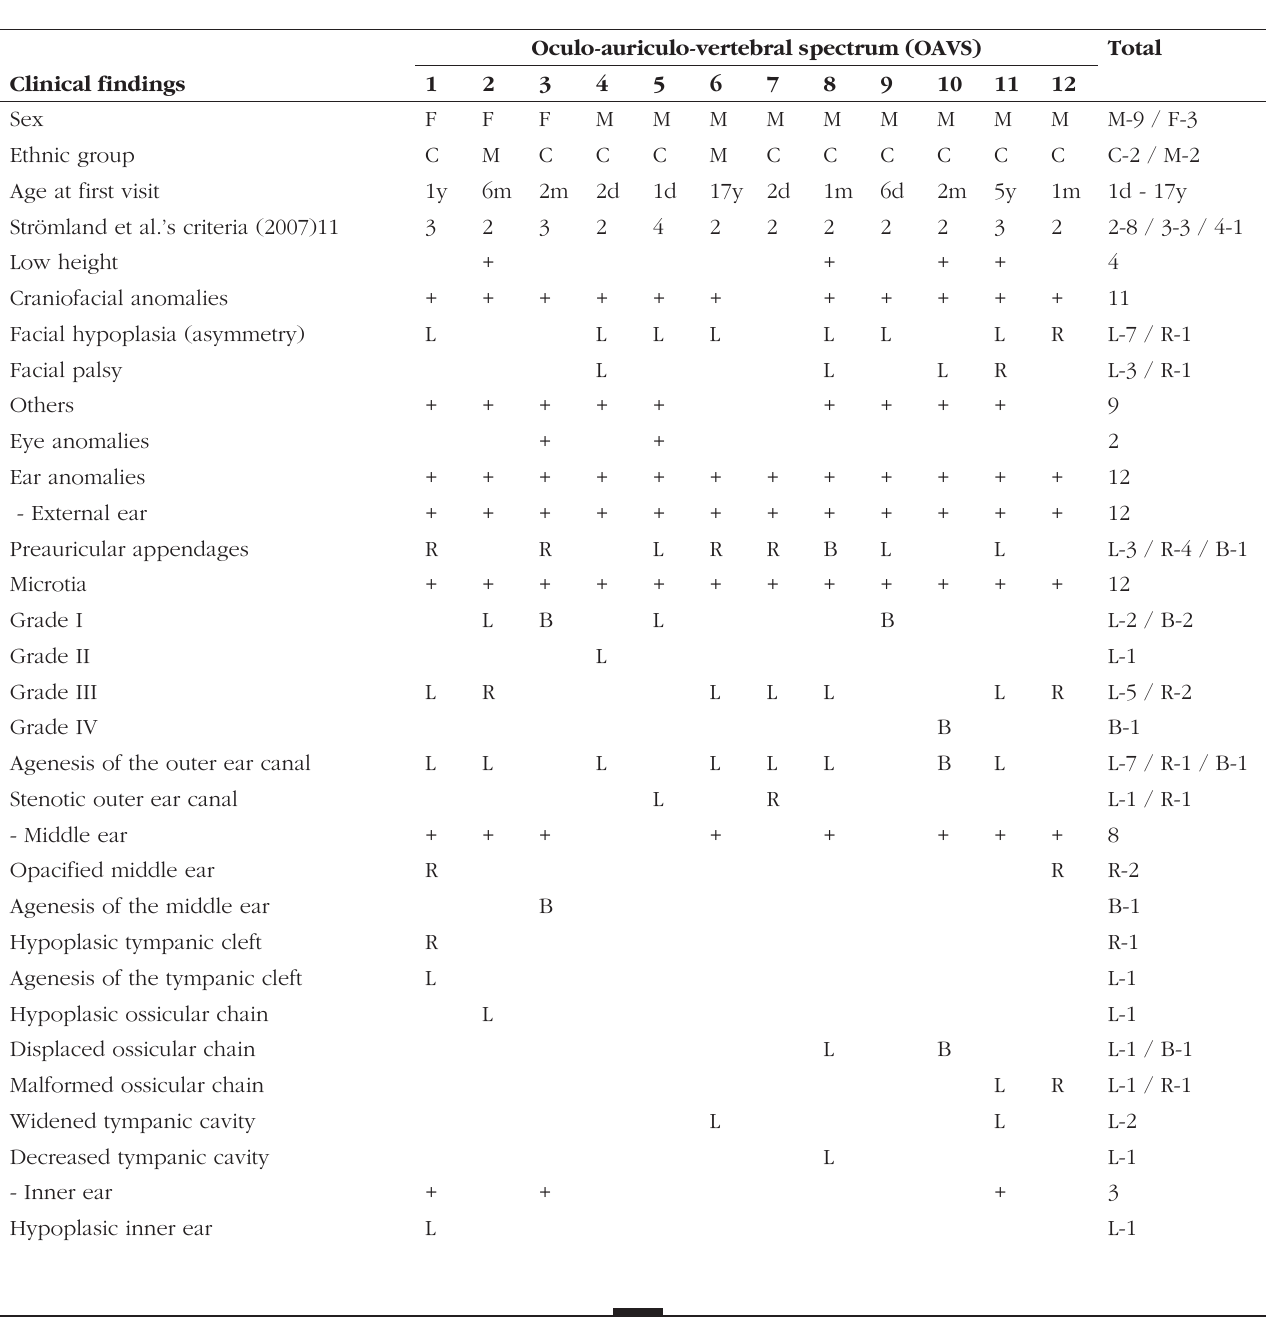
Figure 2. OAVS patient from the study sample (number 12 in Table 1) - the computed tomography of the mastoid showing right ear anomalies (opacified middle ear and malformed ossicular chain). Table 1. Clinical findings in OARS patients in our